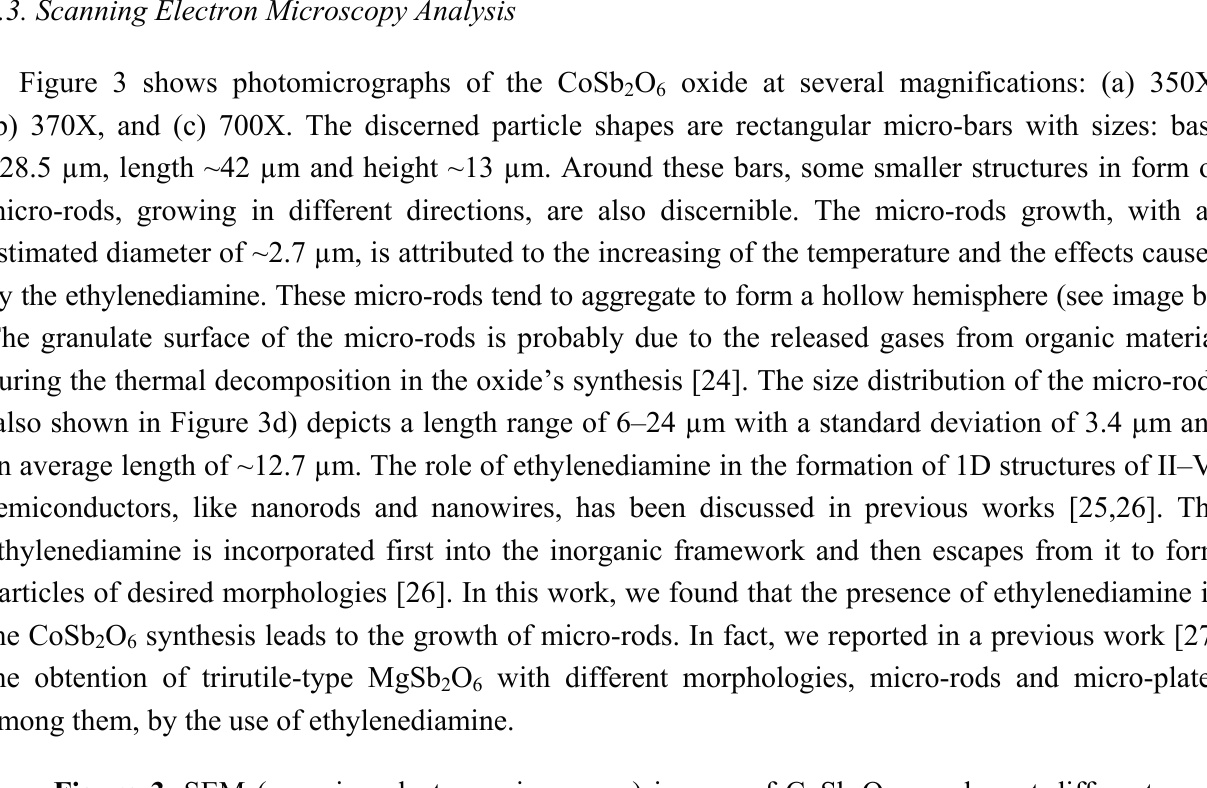
Table 1. Vibration modes of the CoSb